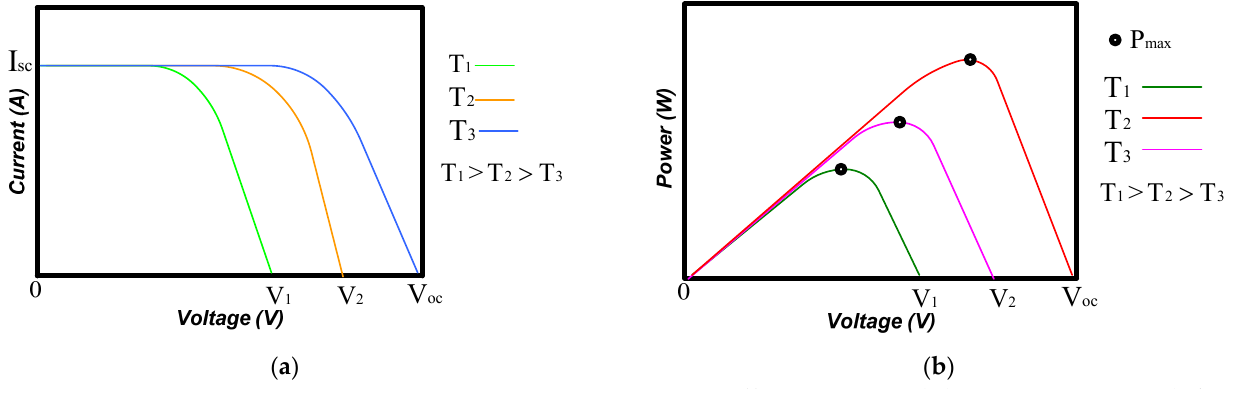
Figure 4. Temperature variations effect on PV module: ( a ) I–V curve and ( b ) P–V Similarly, the output of PV modules is also affected by the change in solar irradiance “W w/m 2 ”, as the output current of PV module depends on irradiance. As irradiance increases, the PV module output current also increases. Thus, the PV module can generate more output power. Figure 5a,b show the effect of irradiance change on PV module (I–V) and (P–V)